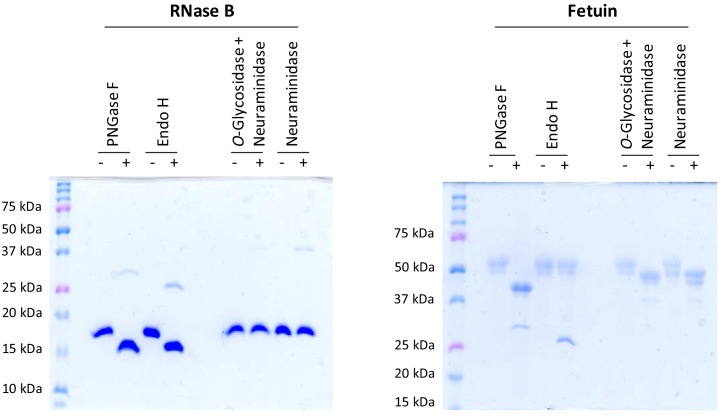
Positive controls for deglycosylation studies.RNase B, a high mannose glycoprotein, has a single N-linked glycosylation site and was used as a positive control for endoglycosidases that cleave N-linked carbohydrates. Fetuin, a glycoprotein containing sialylated N-linked and O-linked glycans, was used as a positive control for endoglycosidases that cleave both N-linked and O-linked carbohydrates.